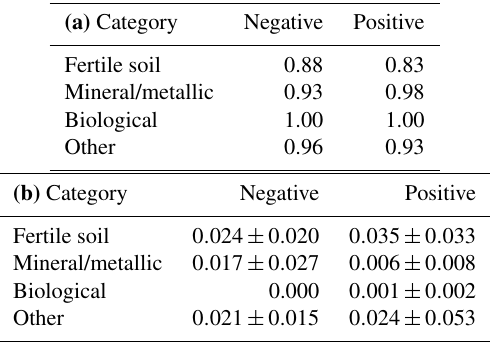
Table 3. Model performance by category and ion mode in a pop- ulation consisting entirely of aerosols within that category. (a) Av- erage classification accuracy where 1 . 0 = 100% precision